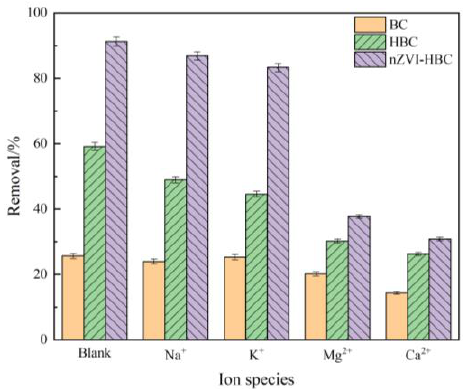
Figure 7. The effect of cations on OTC removal rate.